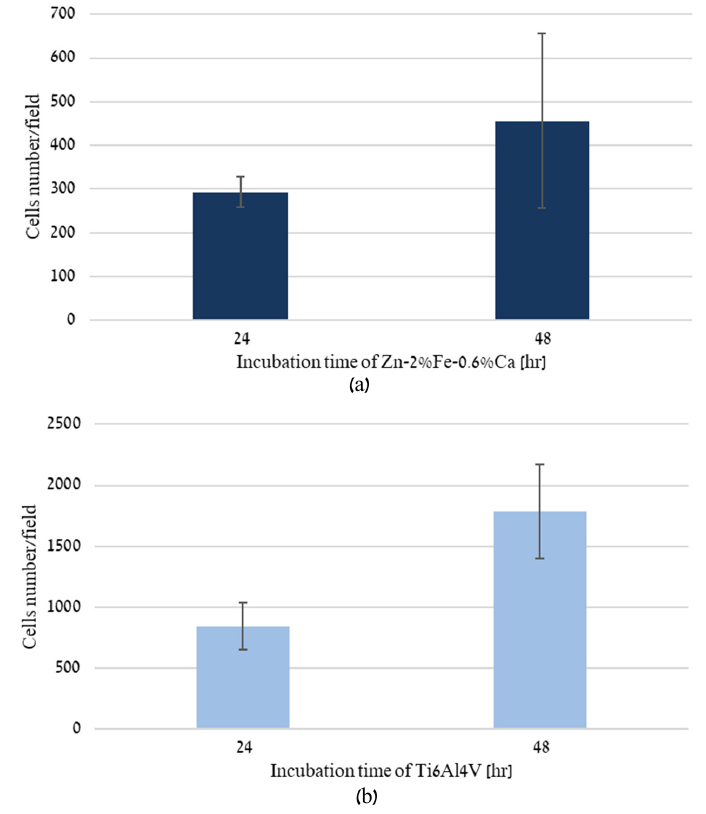
Figure 11. Typical number of cells per unit field after 24 and 48 h of incubation ( a ) Zn-2%Fe-0.6%Ca, ( b ) Ti6Al4V.